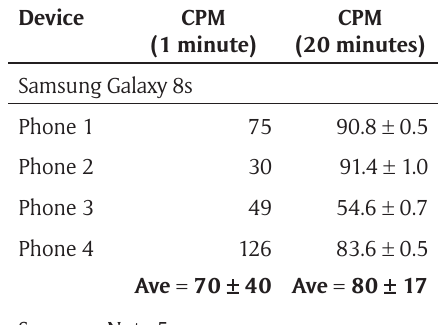
Table 5: Detected counts for the smartphones after 20 minutes with Cs-137